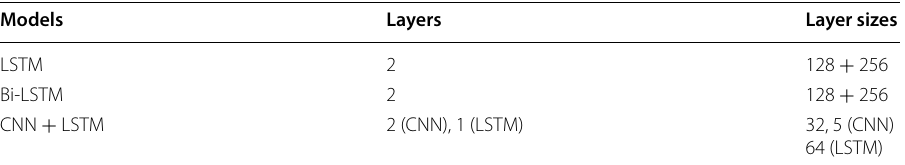
Table 5 The setup of the baseline deep learning models Models